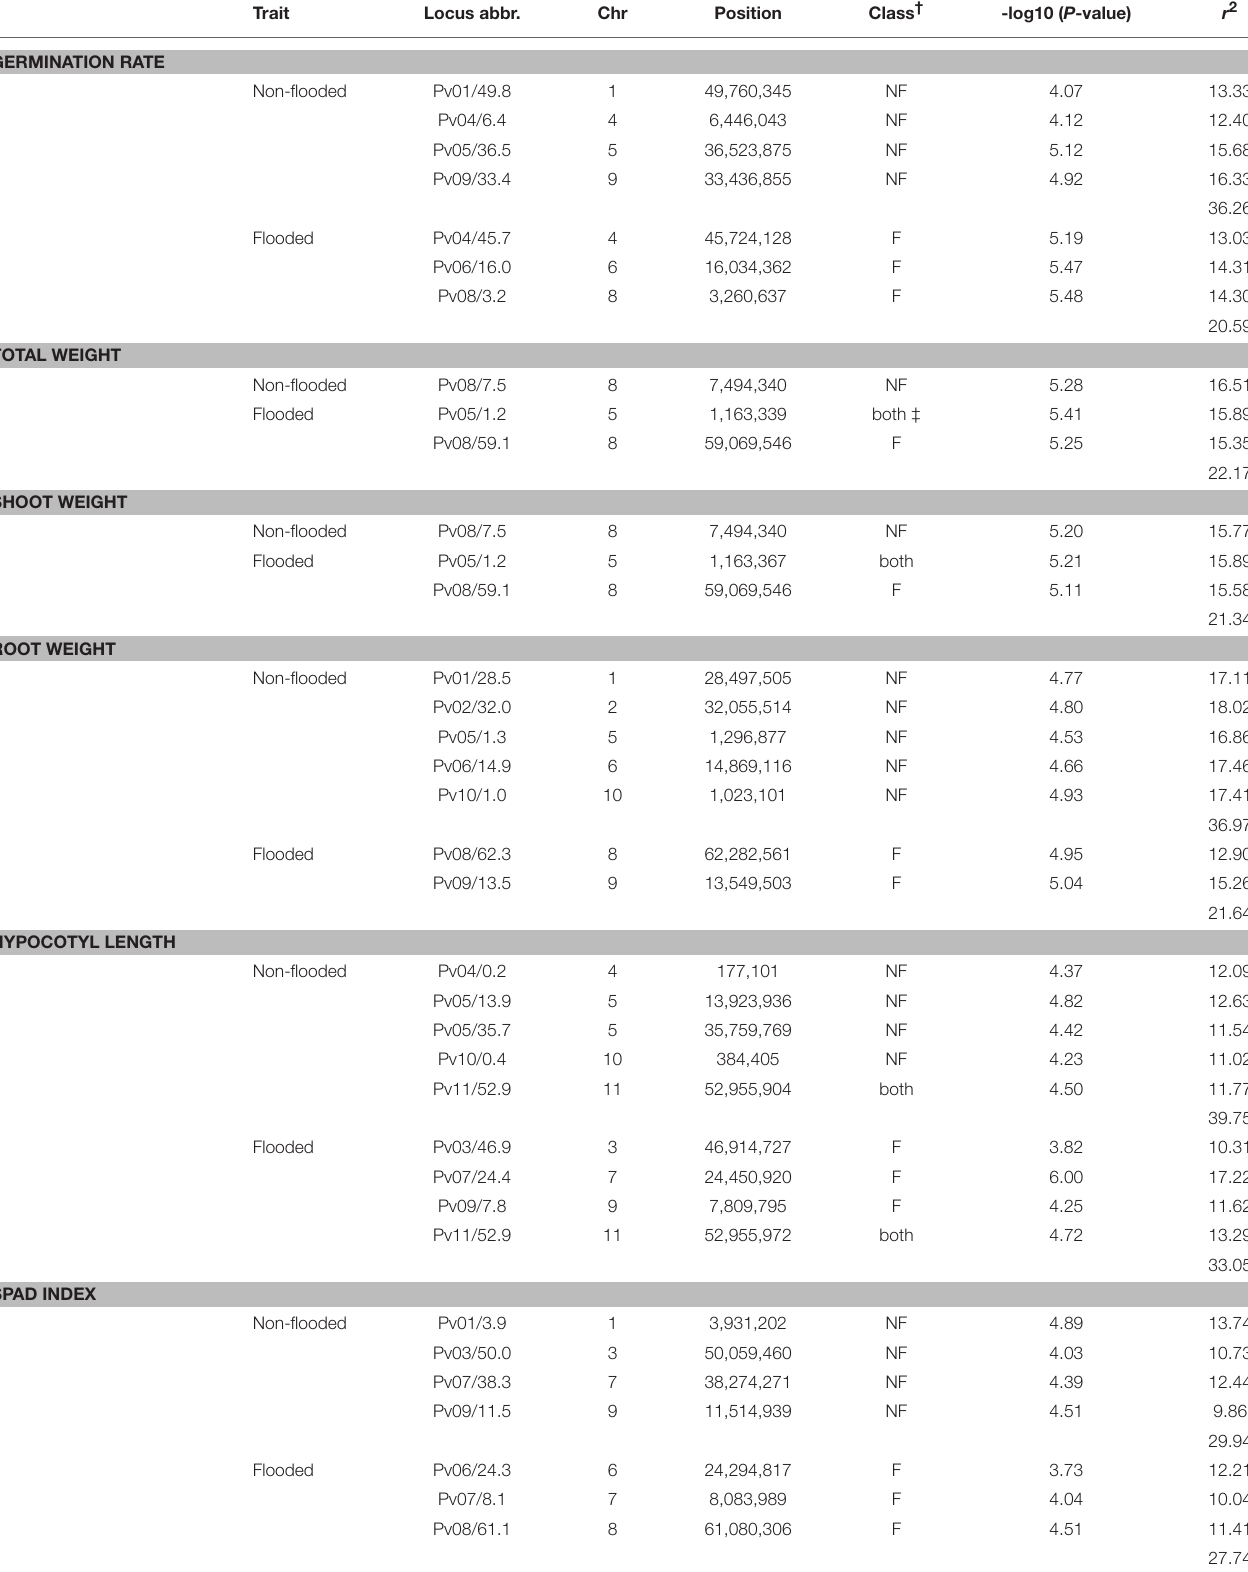
TABLE 4 | Major loci associated with traits in non-flooded and flooded conditions. Trait Locus abbr. Chr Position Class † -log10 ( P -value) r